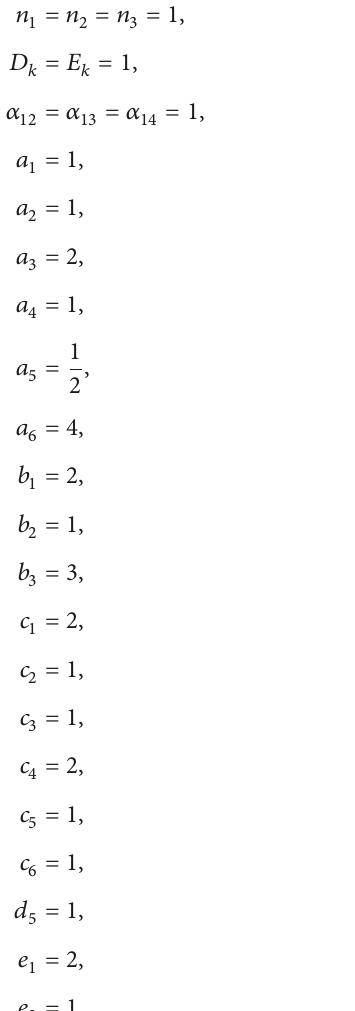
where 𝐴 𝑘 , 𝐵 𝑘 , 𝐶 𝑘 , 𝐷 𝑘 , 𝐸 𝑘 , and 𝐹 𝑘 are constants to guarantee the positivity of 𝑓 . The lumps, interaction between lumps and periodic waves, and interaction between lumps and solitons can be derived by selecting arbitrary functions 𝑔 1 , 𝑔 2 , and 𝑔 3